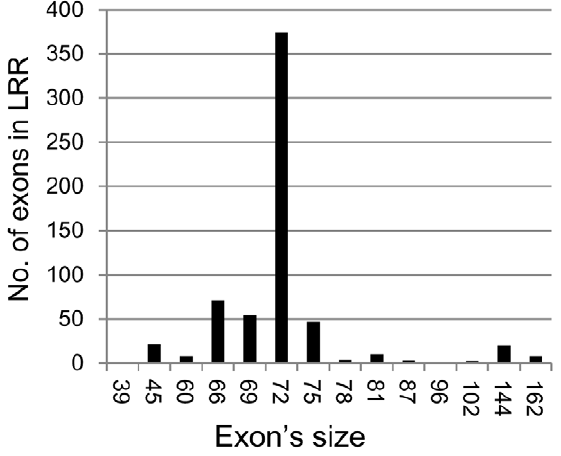
Figure 2. The distribution of the different sizes of exons in the LRR